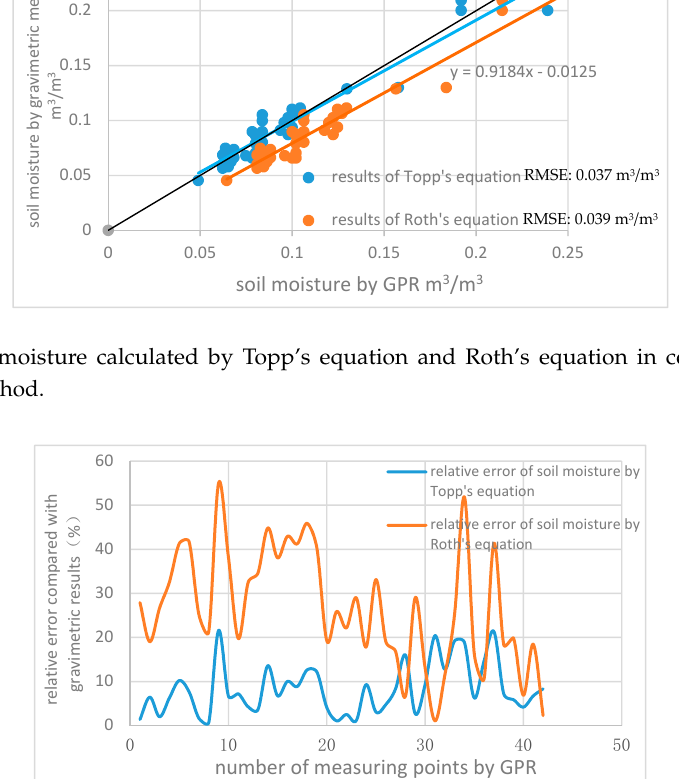
Figure 5. Comparison between relative error of soil moisture calculated by Topp’s equation and that by Roth’s equation.